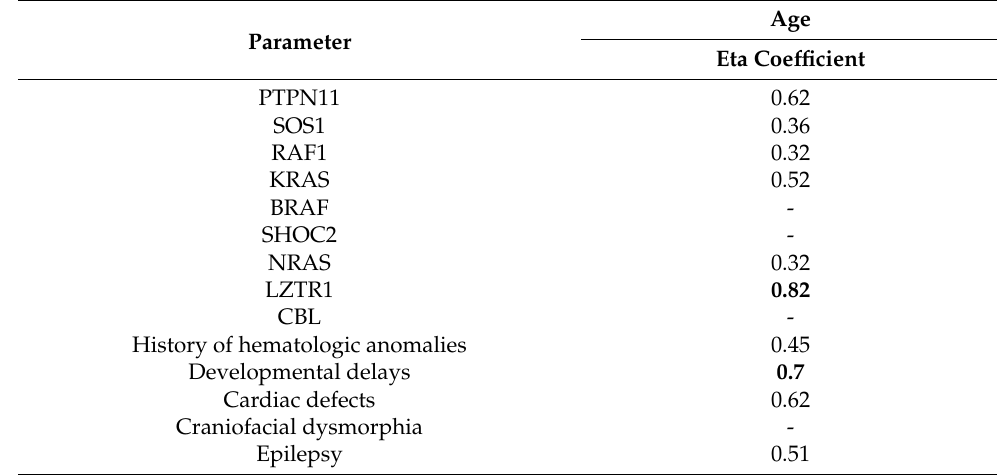
Table 8. Dependency of the age of the patients on individual genetic parameters and other variables in the studied